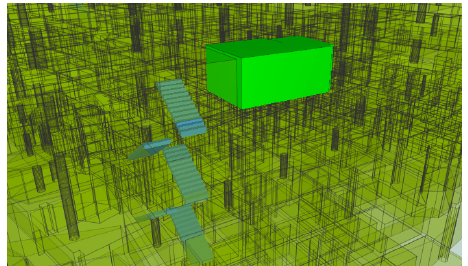
Figure 15. Retrieval of information from both GIS and IFC Components involved in an evacuation planning IFCSpace , IFCstairs and